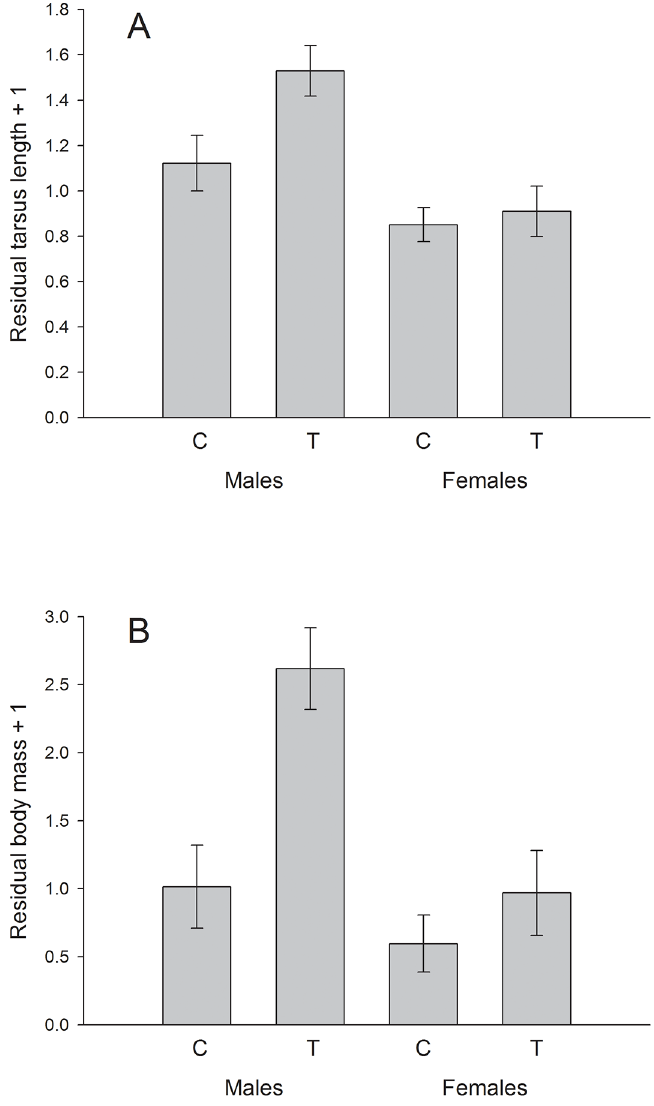
Fig 1. Sex-specific effects of yolk androgens in great tits. Difference in A) fledging size and B) fledging mass of male and female great tit nestlings originating from an egg with experimentally increased yolk testosterone content (T) or a control egg (C). Means ± 1 SE of the residuals (+1) of an analysis that included nest ID, brood size and hatching date are shown. Size difference between C and T males: P = 0.021, size difference between C and T females: P = 0.477; mass difference between C and T males: P = 0.026, mass difference between C and T females: P =